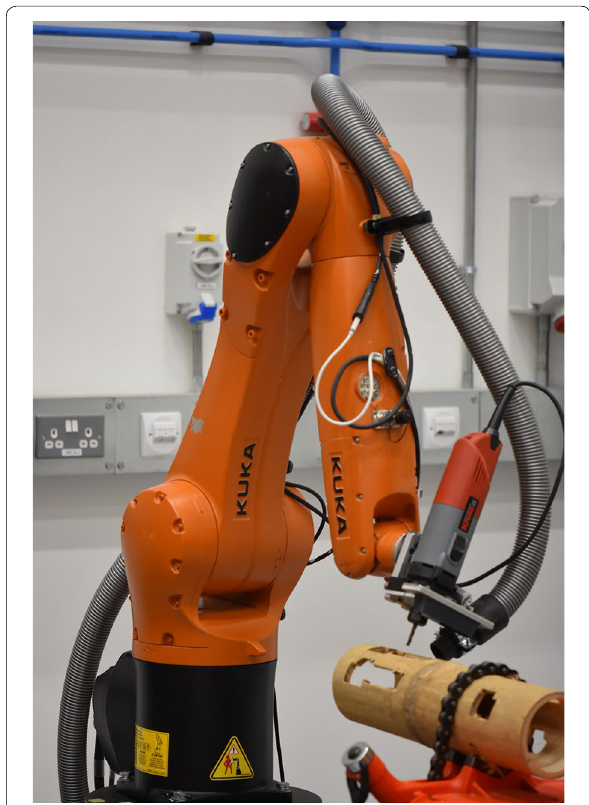
Fig. 2 Industrial robot with milling motor and 3D scanner